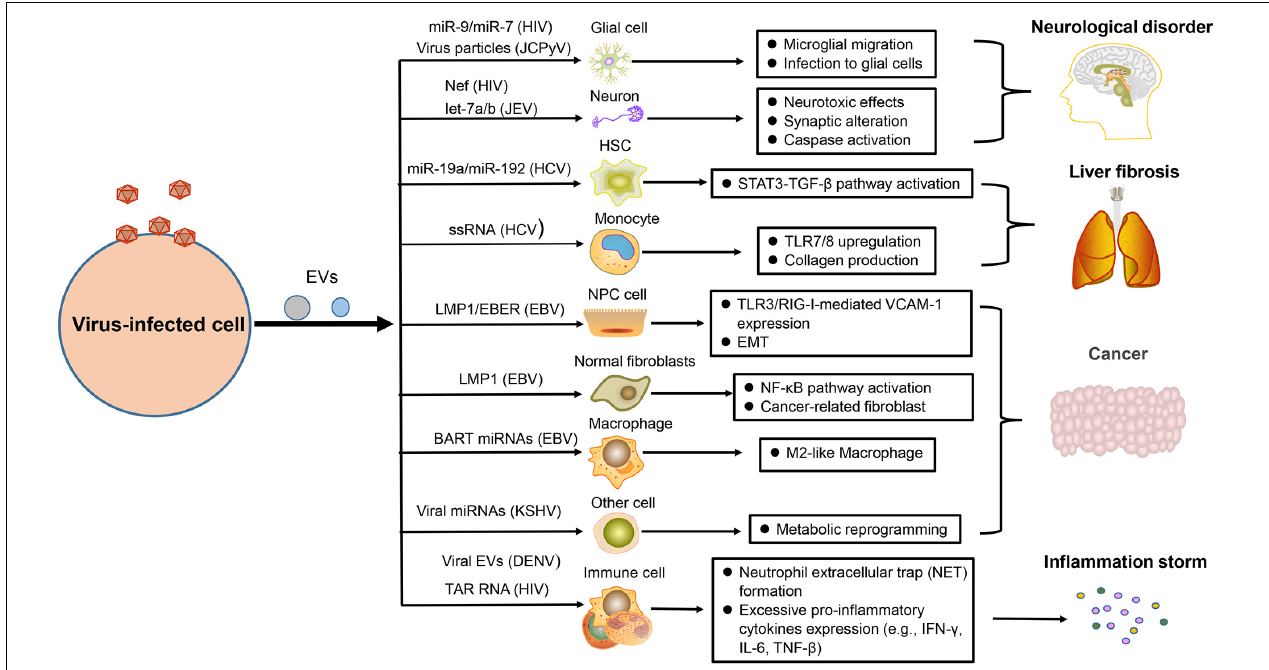
FIGURE 3 | The pathogenesis of virus-regulated EVs. EVs carrying components derived from hosts or viruses under viral regulation can alter the physiological state of the target cells and promote the development of some virus-associated diseases, such as neurological disorder, liver fibrosis, cancer, and inflammation.